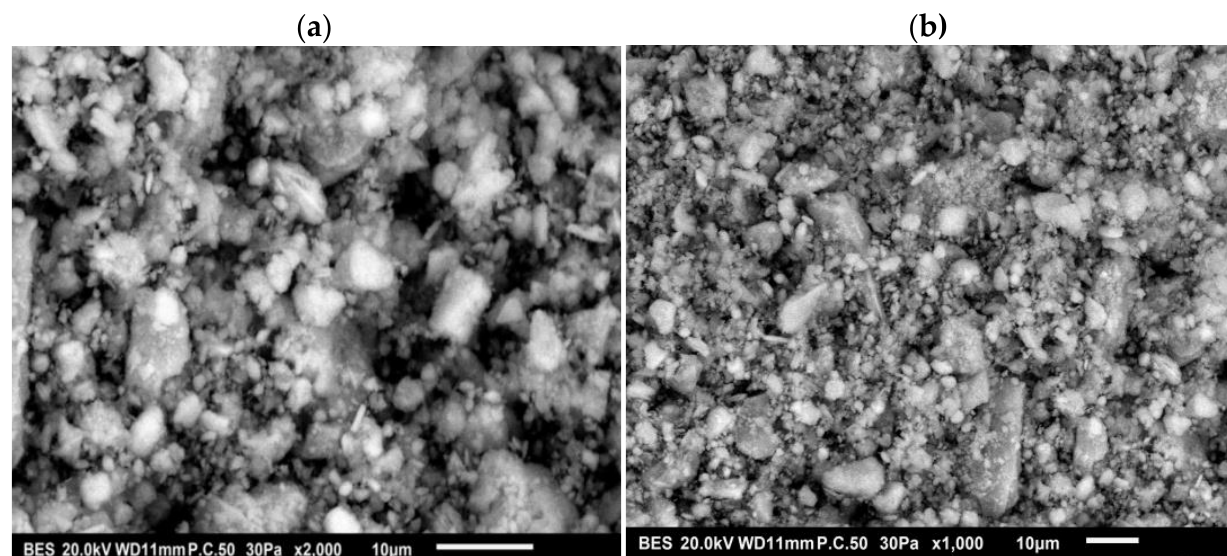
Materials 2023 , 16 , 809 Figure 5. SEM micrographs of the synthesized HAp at ( a ): ×2000 and ( b ): ×1000. Figure 5. SEM micrographs of the synthesized HAp at ( a ): × 2000 and ( b ): × 1000.